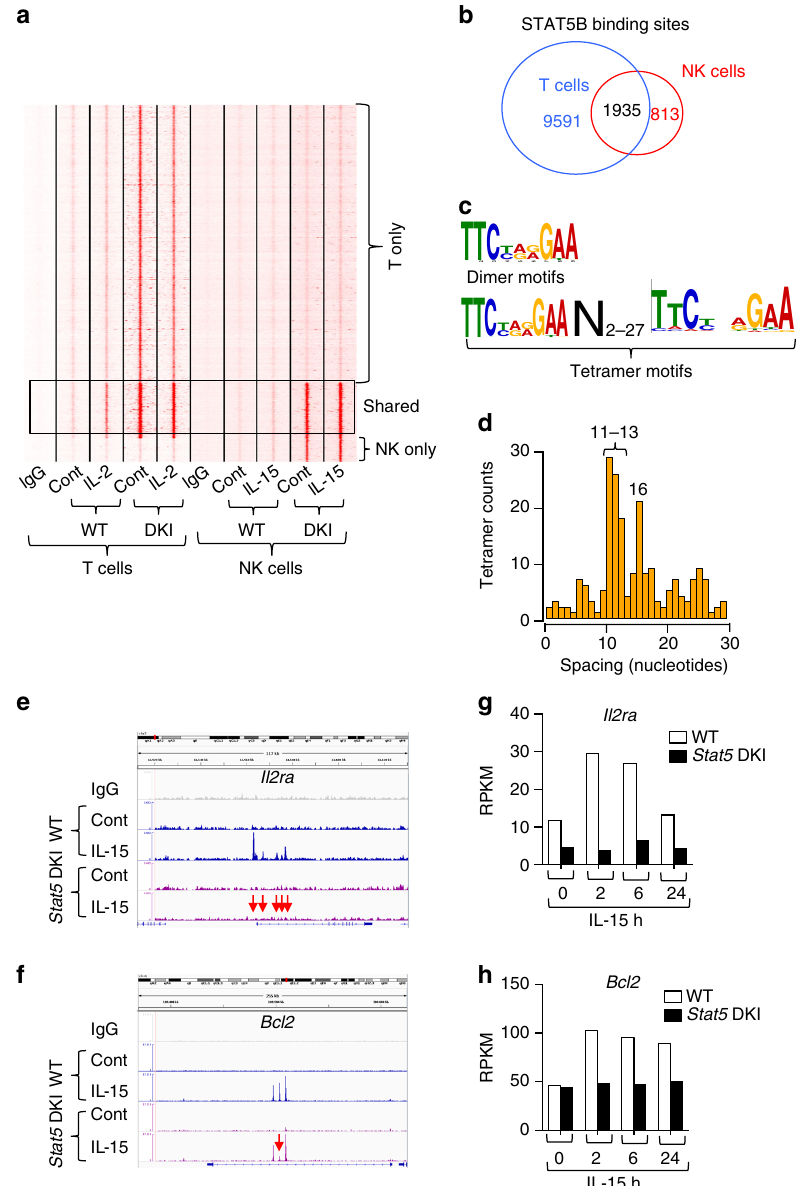
Fig. 4 Identi fi cation of STAT5 tetramer-regulated genes. a , b Comparison of STAT5 binding sites in T and NK cells. a STAT5 binding sites only in T cells (T cell speci fi c) or NK cells (NK-speci fi c) are indicated on the right; STAT5 binding sites shared in both cells are in the black rectangle marked “ Shared ” . b Venn diagram of 9591 T-cell speci fi c STAT5 binding sites (blue), 813 NK-speci fi c sites (red), and 1935 sites shared in T and NK cells (black). c STAT5 dimer (top) and tetramer (bottom) motifs identi fi ed in NK cells. The numbers indicate potential numbers of nucleotides between two tandemly linked tetramer binding sites shown in lower panel for STAT5 tetramer motifs. d Spacing distribution analysis between two tandemly linked tetramer binding sites; preferred spacings between two binding sites in tetramer motifs are marked (at 11 − 13, and 16 nucleotides). e STAT5 tetramer binding in the Il2ra promoter and fi rst intron. f STAT5 tetramer binding in the Bcl2 intronic region (red arrows). g IL-15 potently induces Il2ra mRNAs in WT (open bars) but not in Stat5 DKI (black bars) NK cells. h IL-15 potently induces Bcl2 mRNAs in WT (open bars) but not in Stat5 DKI (black bars) NK